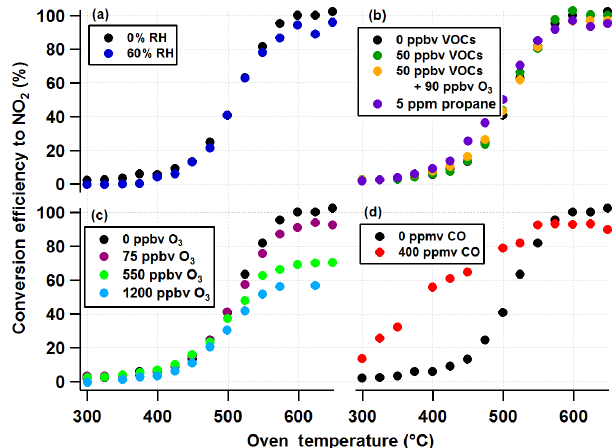
Figure 5. HNO 3 thermograms (1.9slpm, ambient pressure) taken with the NOAA TD-CRDS, with various additions added prior to the TD oven. In each frame, the black solid circles indicate the case without additions. (a, b) No effect is observed when the thermo- gram is taken at high relative humidity or when VOCs are added. (c) Varying amounts of O 3 were added, ranging from ambient lev- els (75ppbv) to extremely polluted levels (1200ppbv), which de- creases the overall conversion at high temperatures. (d) The addi- tion of 400ppmv CO alters the shape of the